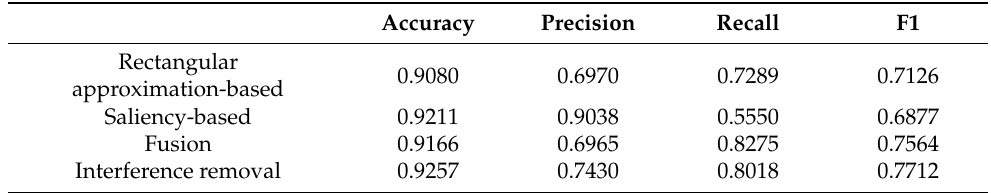
Table 6. Image IV detection